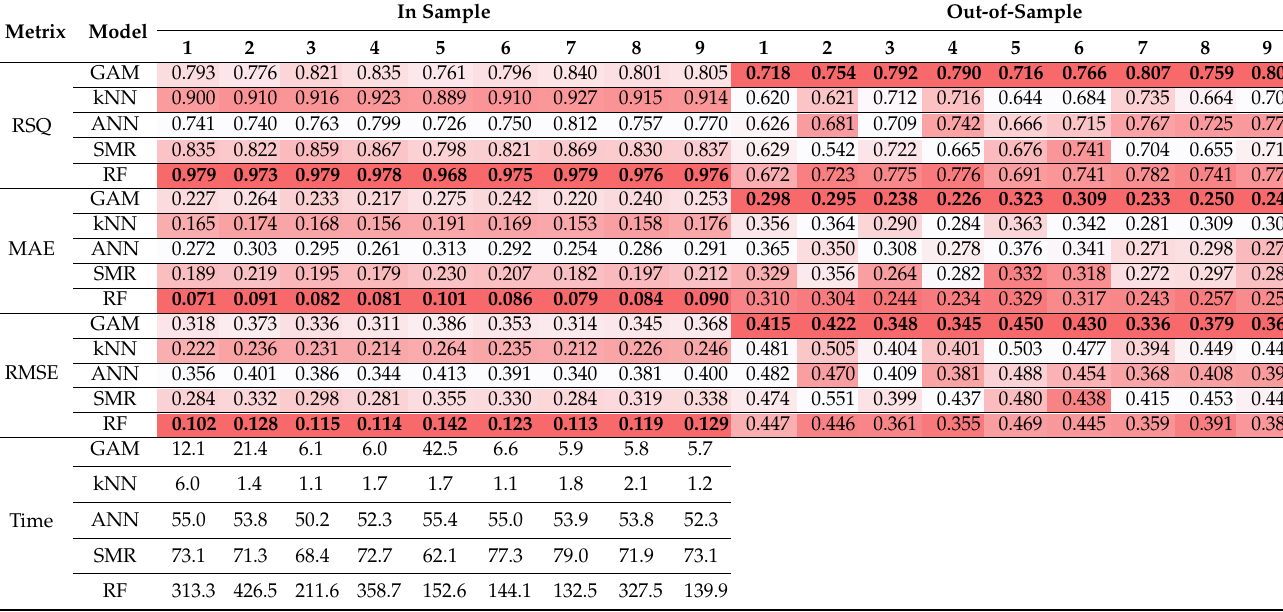
Table 1. Forecasting accuracy and computation time of each method for PV power generation for nine areas. In Sample Metrix Model